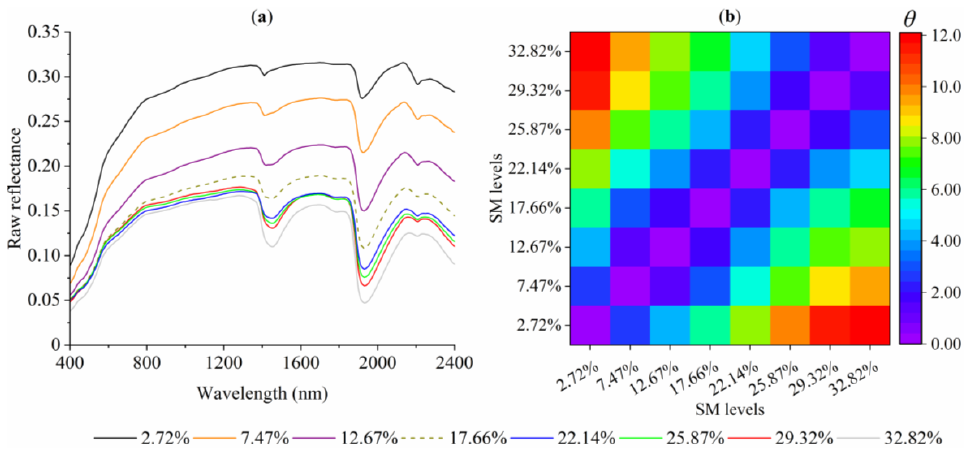
Figure 4. ( a ) Mean reflectance at different SM levels in the calibration dataset and ( b ) two-dimensional sample–sample spectral angle (SA, by angle) between different SM levels. θ : spectral